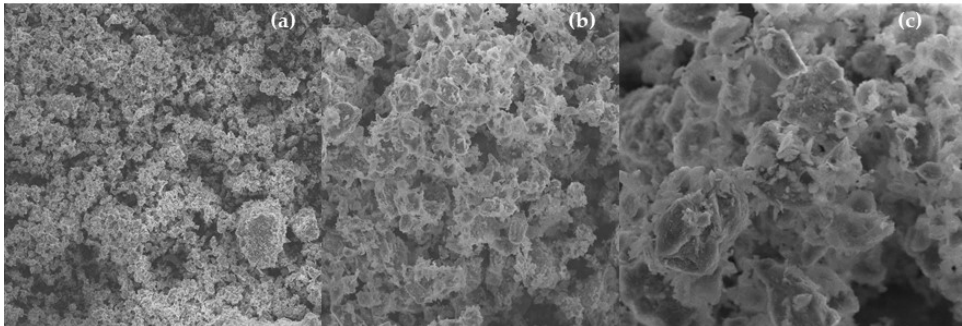
Figure 7. SEM of activated carbon pellets impregnated with 10.0 M NaOH (MAG: 338× ( a ); MAG: 1.67 k× ( b ); MAG: 5.00 k× ( c )).